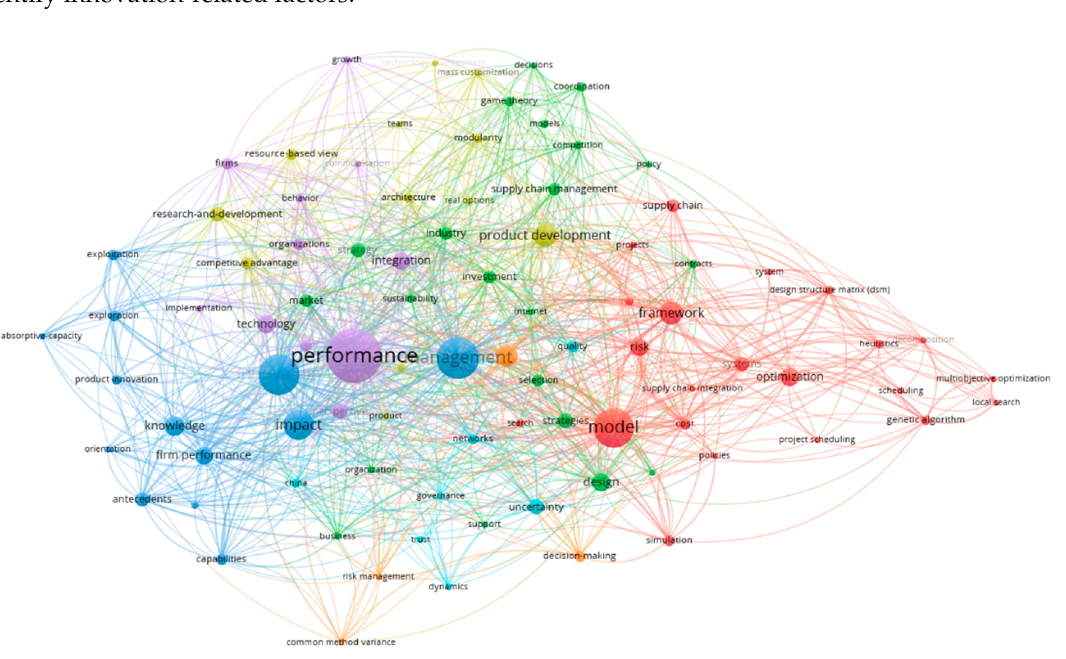
Figure 1. VOS Viewer: keywords from the IEEE Transactions on Engineering Management Journal. There were seven clusters detected in this journal; the total number of keywords was 90.